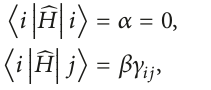
have 𝑆 = 0 , to which a singlet ground state corresponds.